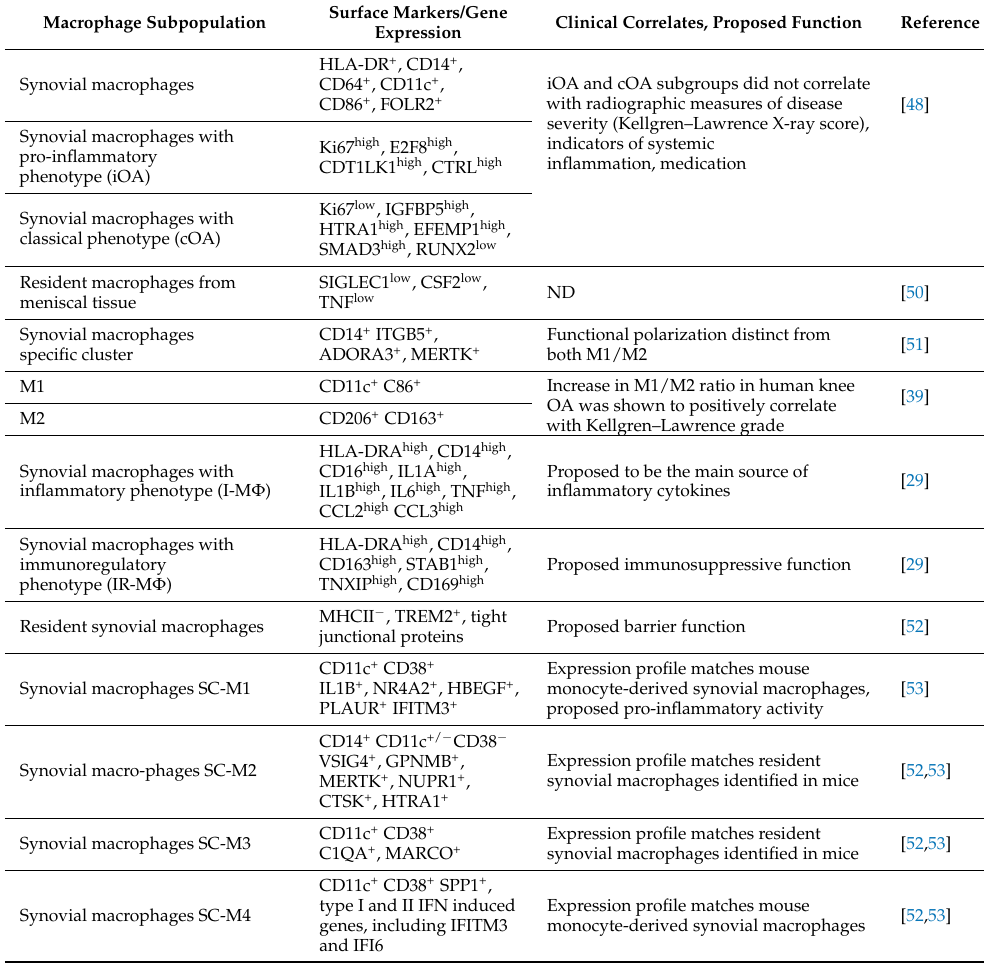
Table 1. Summary of macrophage populations identified in human knee OA. Macrophage